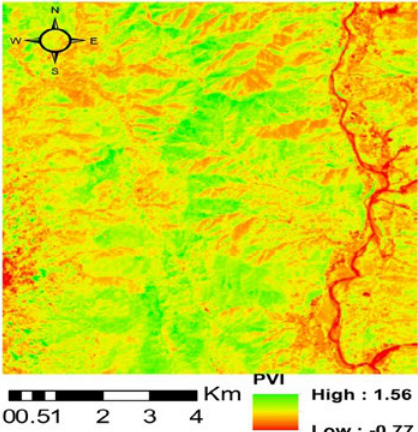
Fig. 4(a). Scatterplot between AGB and PVI Fig. 4(b). PVI computed from Landsat-8 Fig. 4(a): Scatterplot between AGB and PVI Fig. 4(b): PVI computed from Landsat ‐ 8 Image